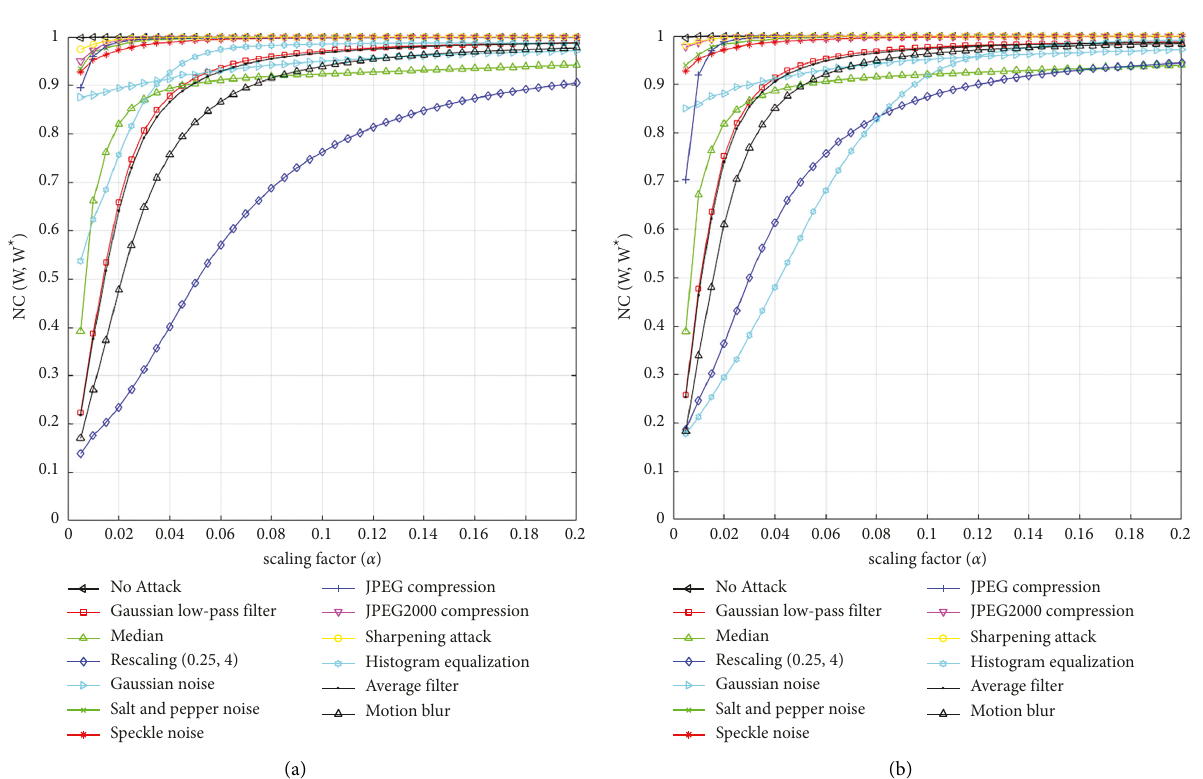
Figure 14: NC results of tests under different attacks according to scaling factor change. (a) Human blood. (b) Cancer cell